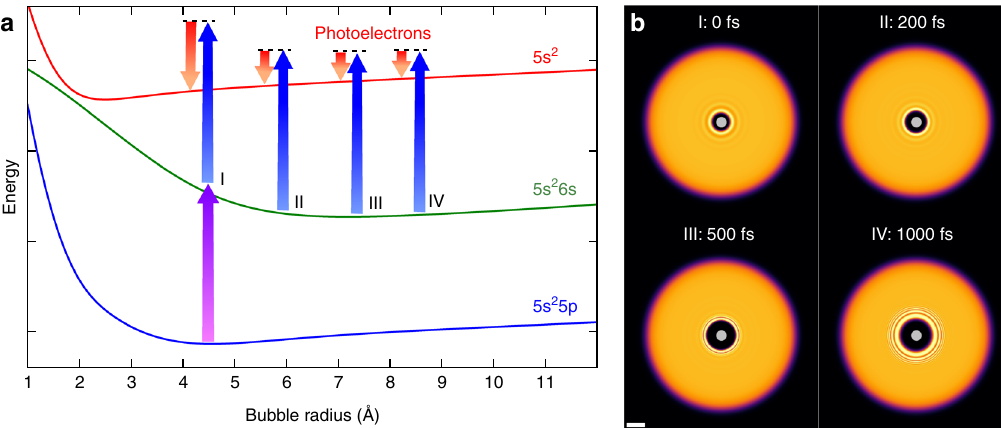
Fig. 1 Temporal evolution of the In – He N system after photoexcitation. a Sketch of the In – He N potential energy surfaces as a function of the bubble radius for In in its ground [5 s 2 5 p ( 2 P 1/2 ), blue], lowest excited [5 s 2 6 s ( 2 S 1/2 ), green], and ionic ground state [5 s 2 ( 1 S 0 ), red]. The purple arrow indicates pump excitation at 376 nm, blue arrows indicate probe ionization at 405 nm for characteristic delay times, and red arrows correspond to the PE kinetic energy, as measured by TRPES. b Helium density distributions of a He 4000 droplet with an In atom located in the center for selected times after photoexcitation, as calculated with TDDFT. Scale bars, 10